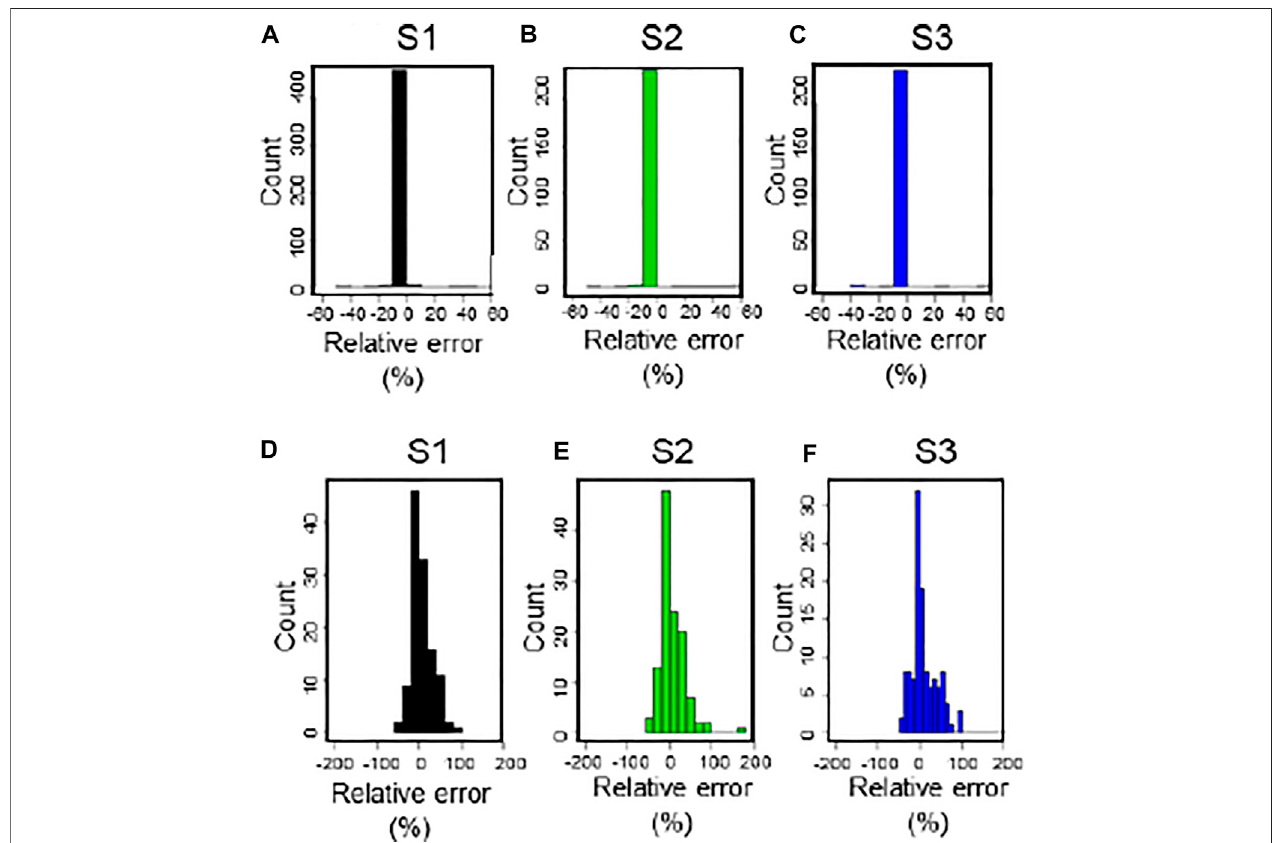
FIGURE 7 | Histograms of REIS for the calibration period [i.e., (A – C) ] and validation period [i.e., (D – F) ]. (Note: S1, S2, and S3 represent Yichang station, Hankou station, and Datong station).